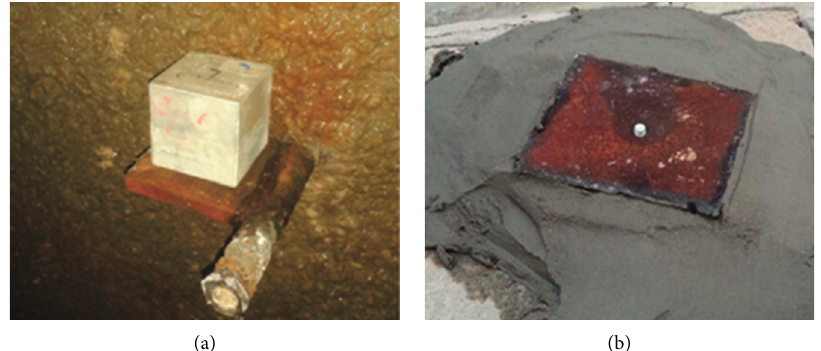
Figure 5: Photographs of installed sensors. (a) Measuring point in the tunnel. (b) Measuring point on the slope